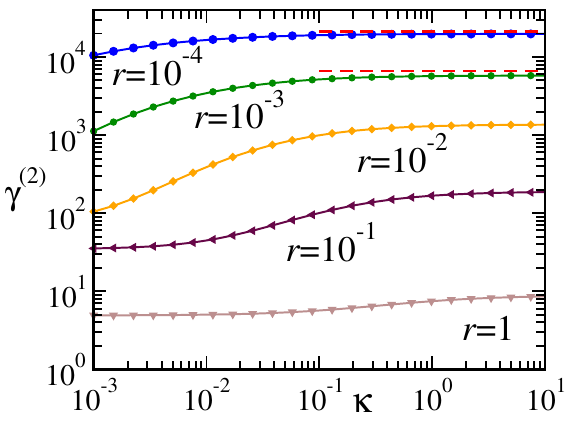
Figure 5: Dependence of the correction γ ( 2 ) to the friction coefficient γ (see Eqs. (71) and (72)) on the trap stiffness κ for various values of r , decreasing from top to bot- tom, in spatial dimension d = 3. The horizontal dashed lines for r = 10 − 3 and 10 − 4 correspond to the asymptotic behavior given by Eq. (74). The interaction poten- tial used for this plot is V ( z ) = e − z 2 / ( 2 R 2 ) with R = 2 and the other parameters are ν = D = T =